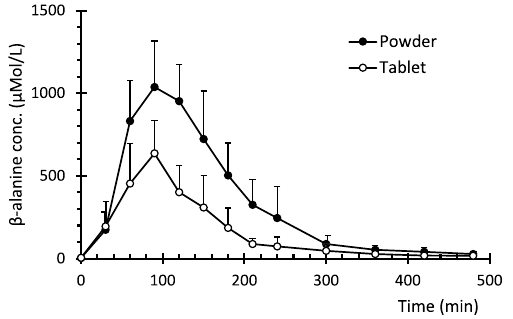
Figure 1. Plasma pharmacokinetic profile of β -alanine after the oral administration of 89.7 mMol to healthy volunteers. ( ●) controlled -release powder blend formulation, ( ○ ) sustained-release tablet. Symbols represents Mean ± SD.